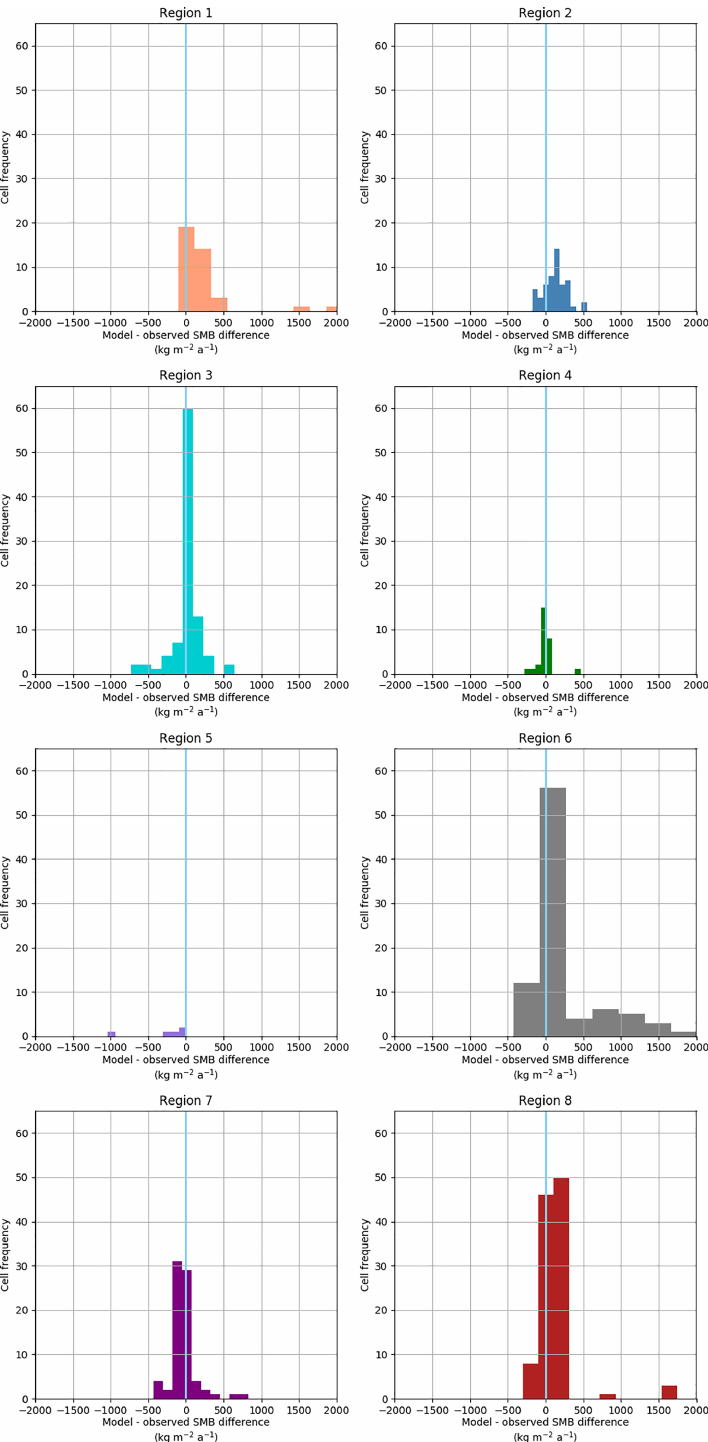
Figure 13. As in Fig. 12 but broken down into basins as marked in Fig. 1. Axes have been normalized for the eight drainage histograms to highlight differences between the number of comparison points per